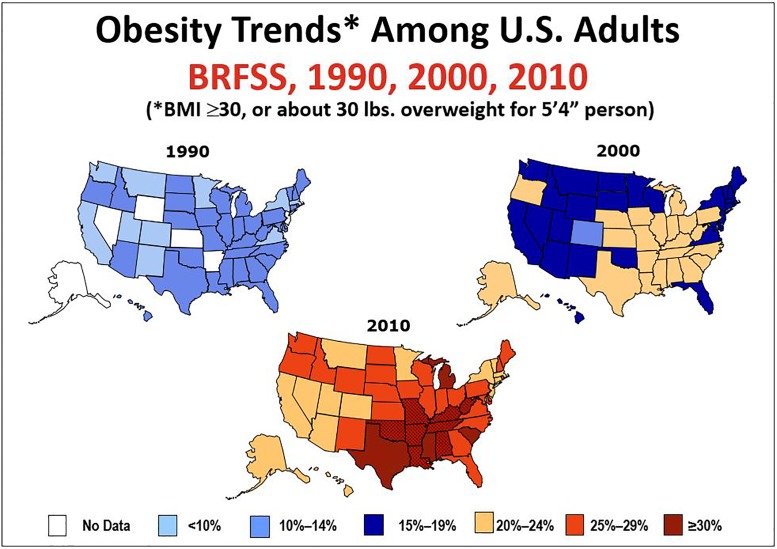
Source: Centers for Disease Control and Prevention, National Center for Chronic Disease Prevention and Health Promotion, Division of Population Health. BRFSS Prevalence & Trends Data: 1990, 2000, 2010.